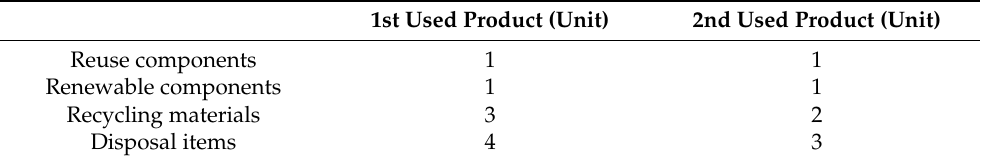
Table 2. Components of each product.